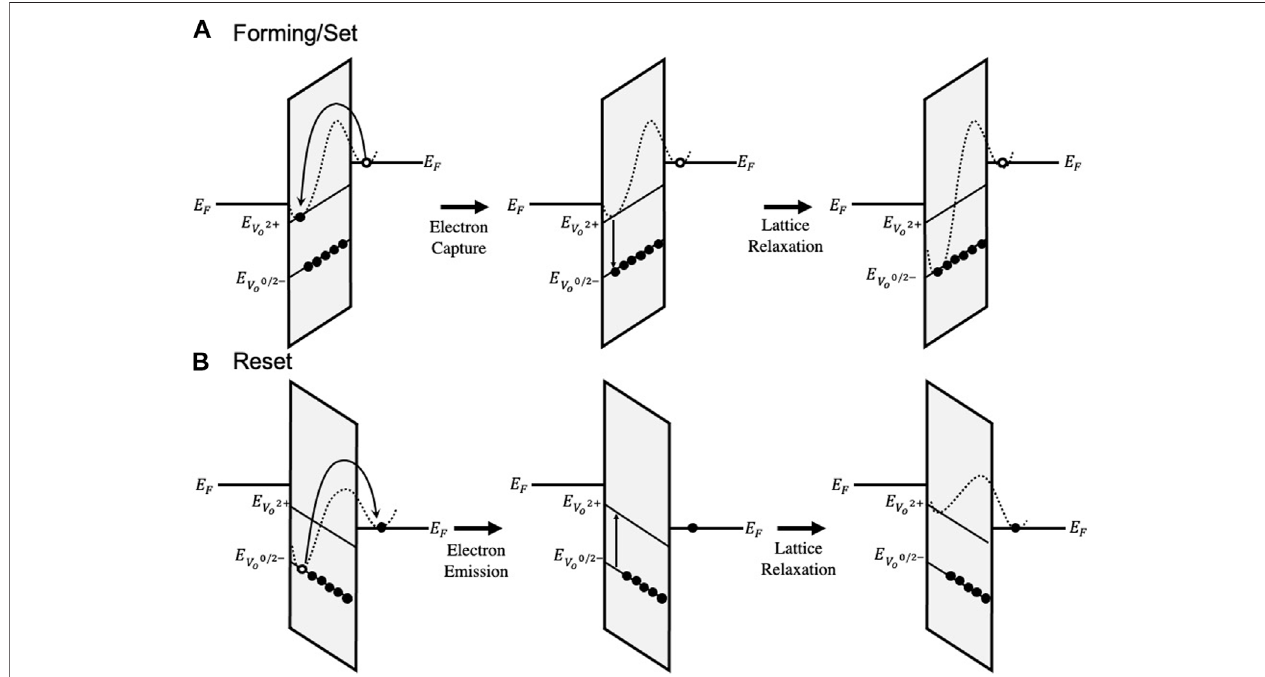
FIGURE 2 | Depiction of electron capture and emission as band-to-trap and trap-to-band, respectively for a trap located below the Fermi level of the cathode (i.e. Δ E < 0). (A) The forming and set process is facilitated by electron capture and lattice relaxation. (B) The reset process is facilitated by electron emission and lattice TF relaxation.